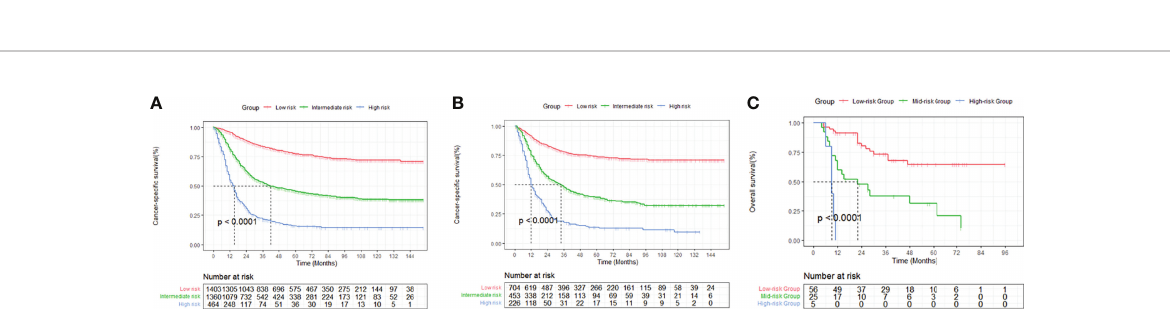
FIGURE 5 | The decision curve analysis (DCA) of CSS nomogram at 3- (A) , and 5-years (B) in the primary cohort, at 3- (C) , and 5-years (D) in the internal validation cohort and at 3 (E) , and 5-year (F) in the external validation cohort.